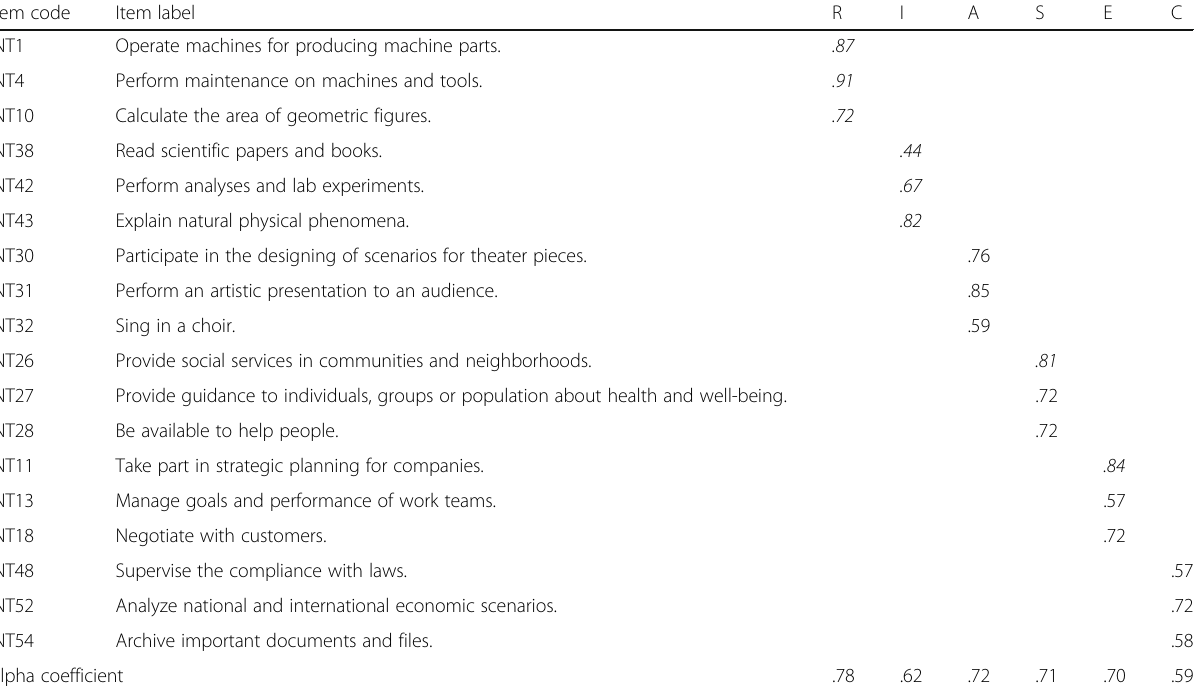
Table 5 Confirmatory factor analysis of data from 292 undergraduate students Item code